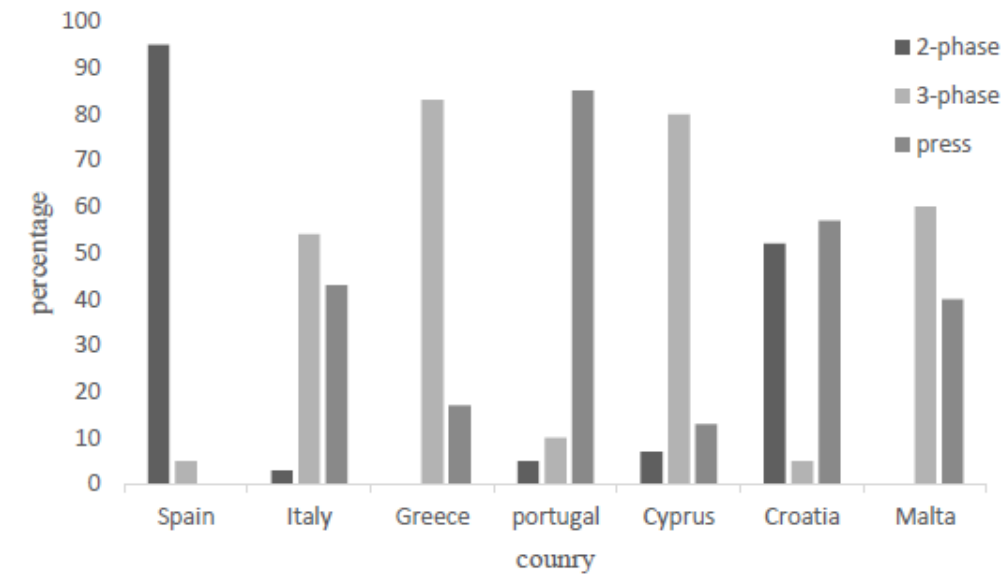
Fig. 3. Technologies used by some countries in olive oil extraction